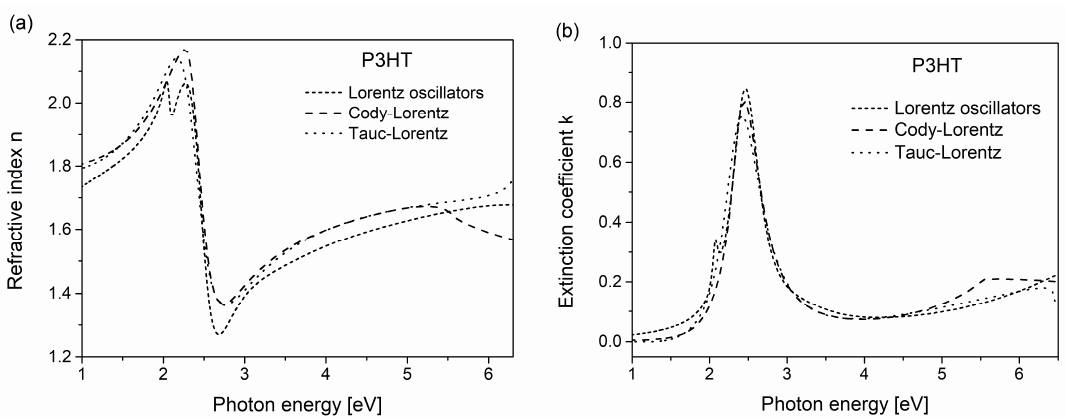
Figure 8. Dispersion relations of optical constant for P3HT ( a ) refractive index, ( b ) extinction coefficient.